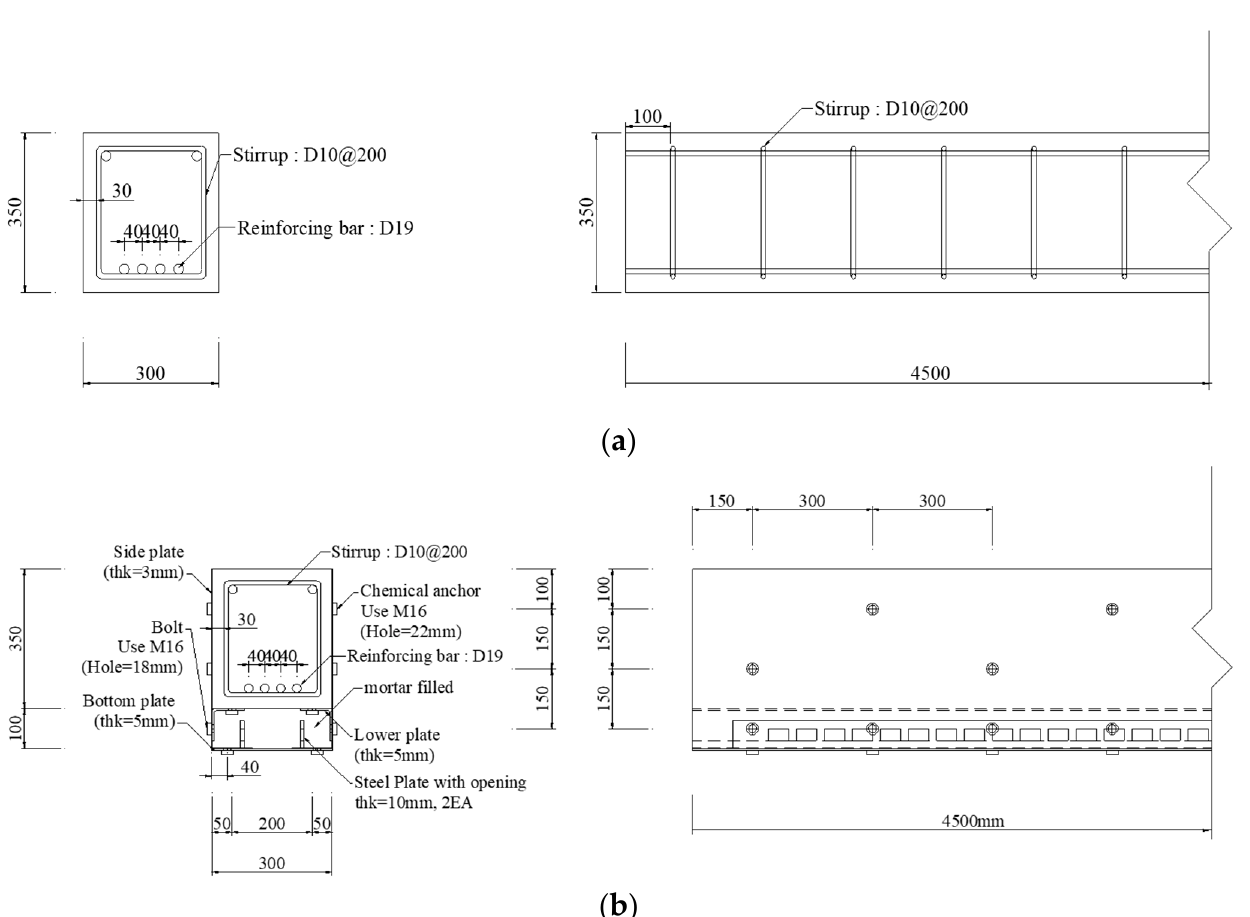
8 of 17 Figure 6. The test parameters: ( a ) The fabrication of proposed retrofitting system in the experi- ment; ( b ) test parameters. Table 3. The test specimen parameters. No.